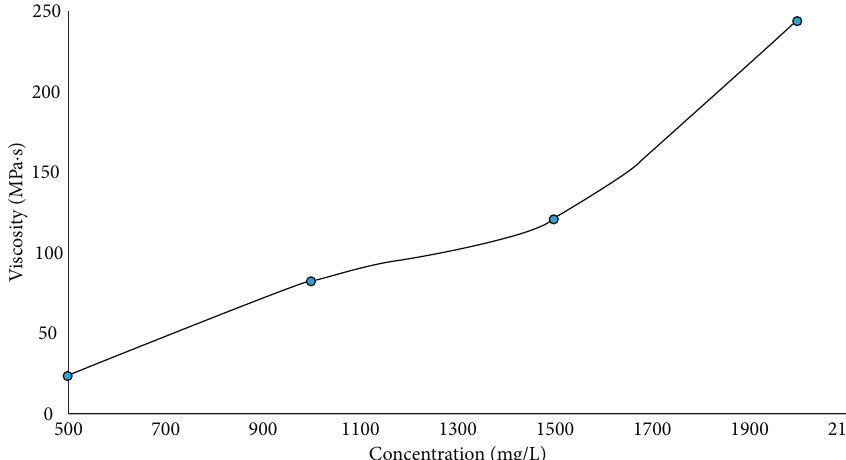
Figure 4: Effect of polymer concentration on